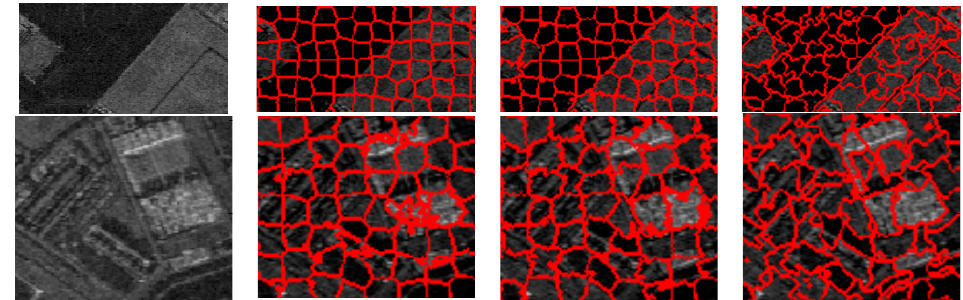
Figure 12. EMISAR image patches A1 and A2 (first column from top to bottom) and corresponding superpixels provided by standard SLIC (second column), compound method (third column), and proposed algorithm (fourth column).